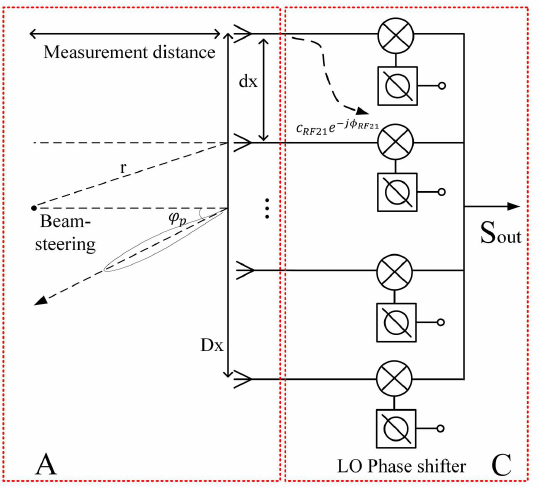
Figure 2. Simplified block diagram of a linear phased array with RF coupling between channels .